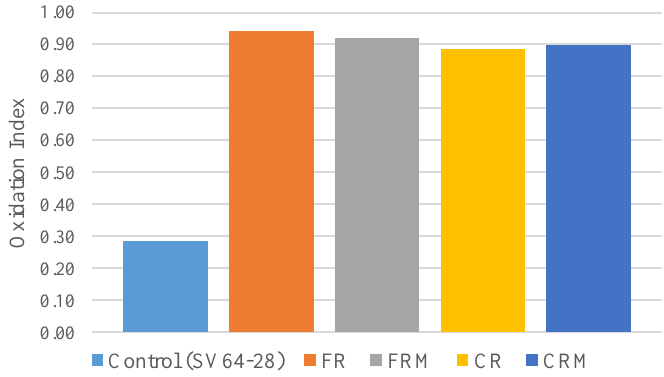
Figure 9. FTIR carbonyl oxidation indices.